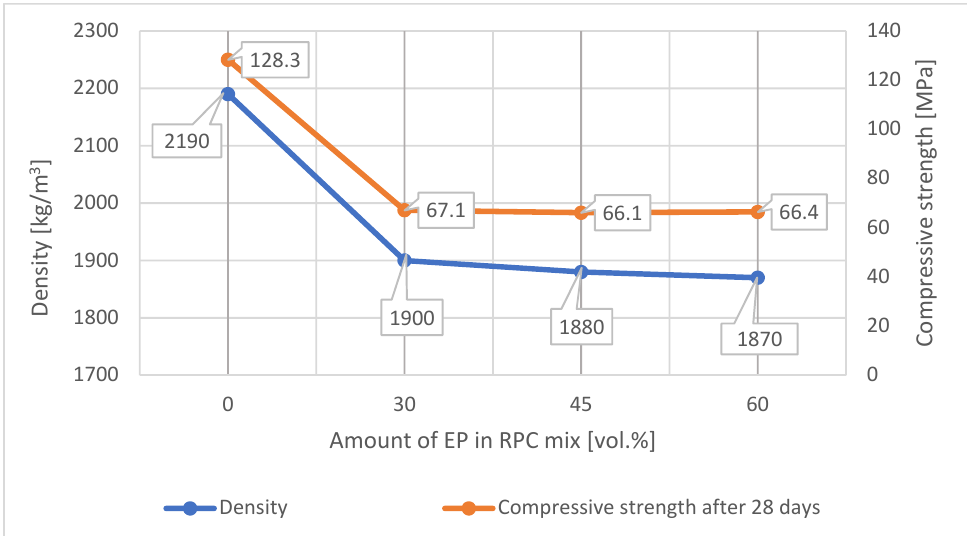
Figure 17. Change in density and compressive strength depending on the amount of EP in the RPC.